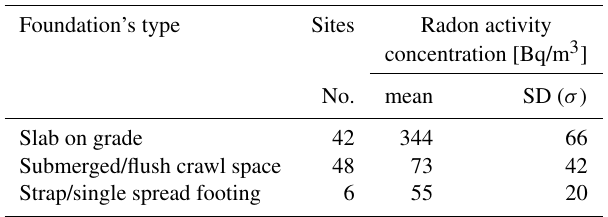
Table 4. Mean value of radon activity concentrations in indoor air, measured at the basement floor of buildings, according the founda- tion type.